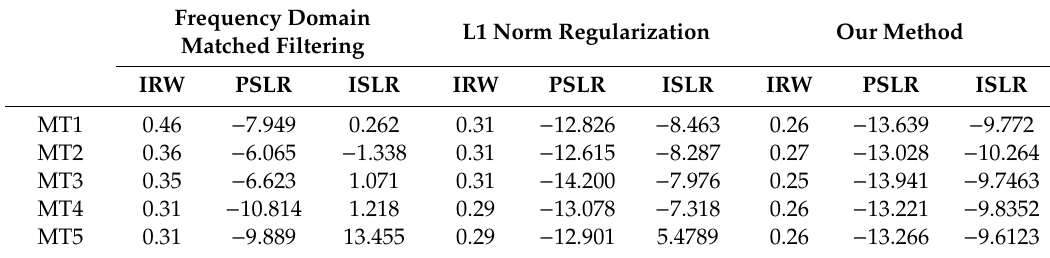
Table 3. Point target analysis